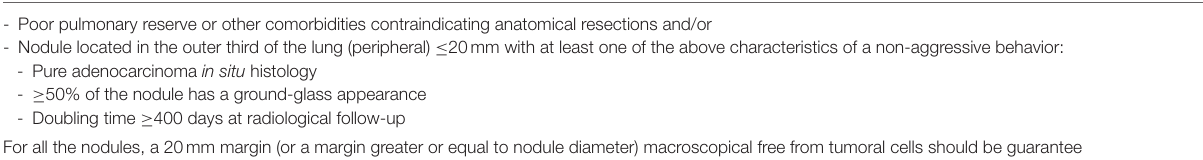
TABLE 1 | General indication for wedge resection.